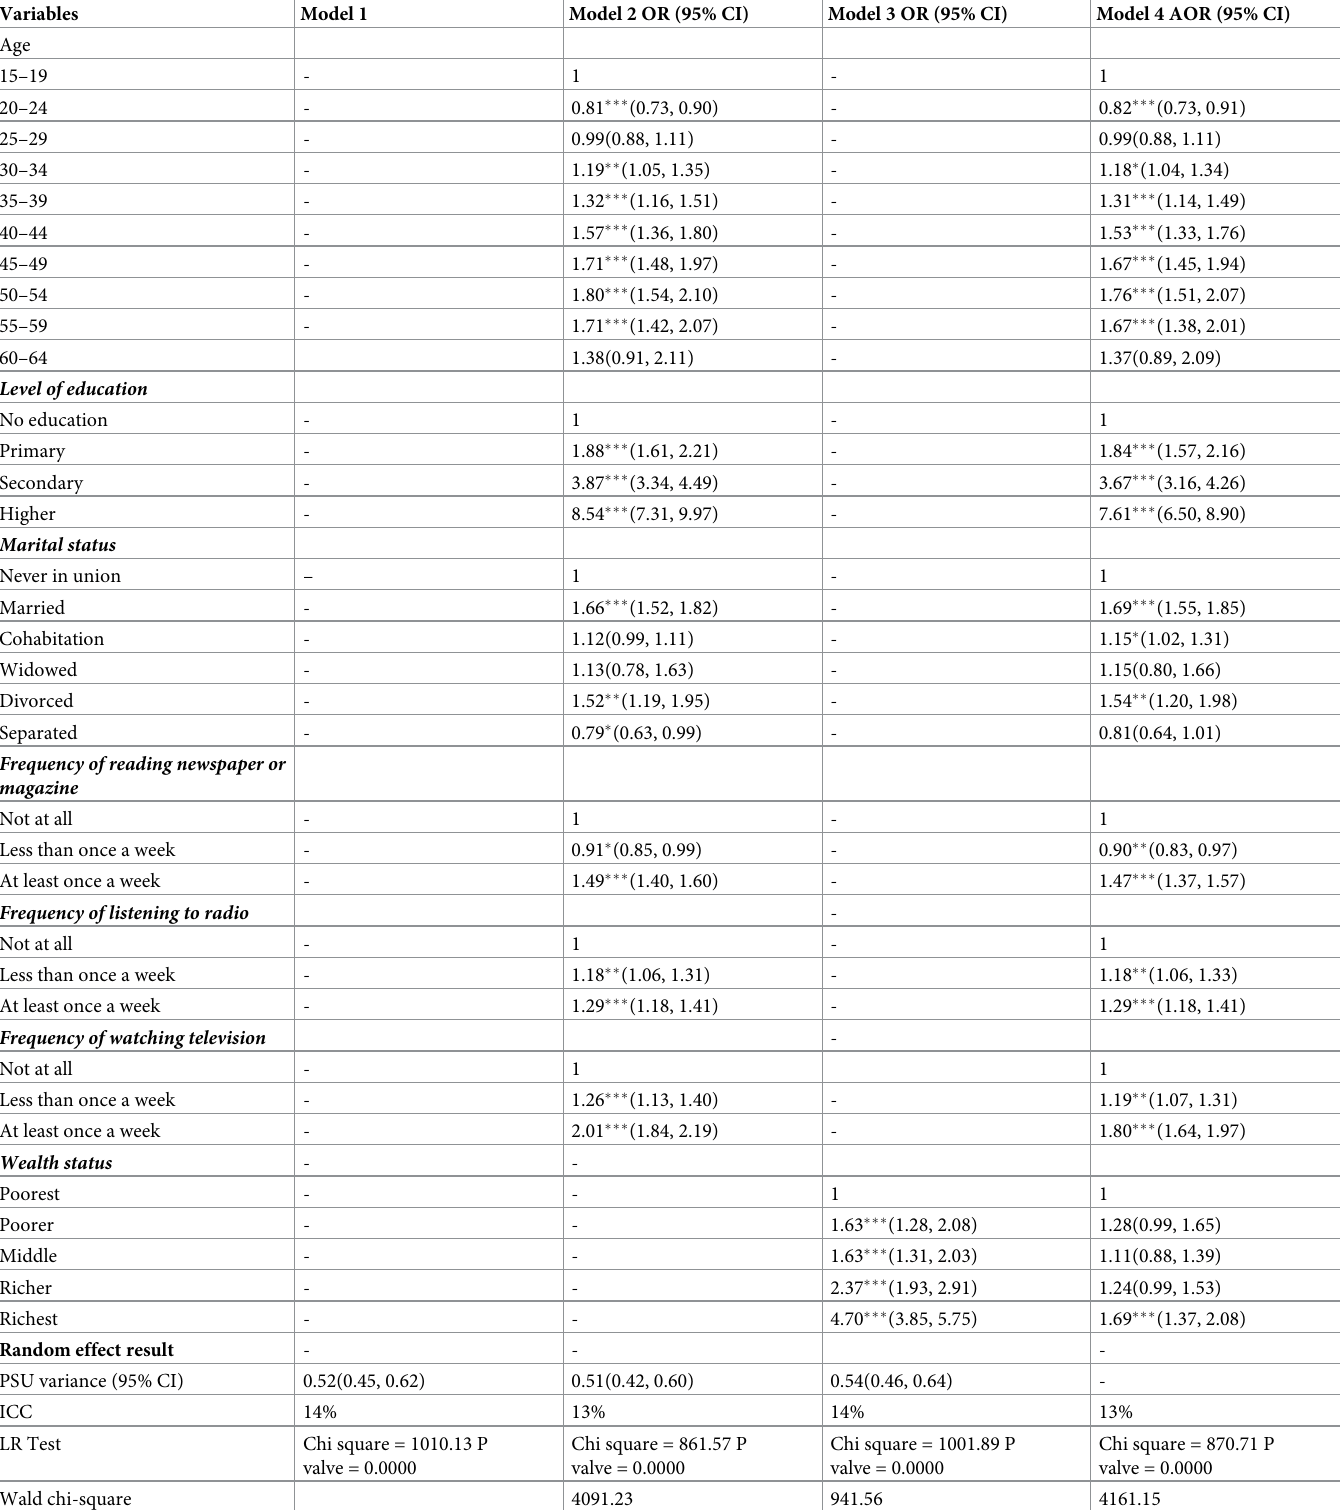
Table 2. Multilevel binary logistic regression results on the factors associated with health insurance coverage among males in